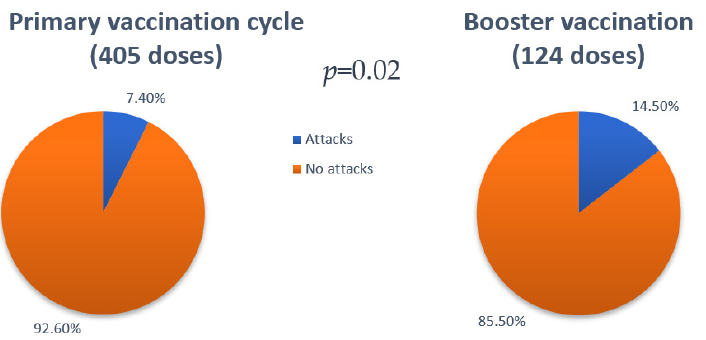
Figure 2. Difference regarding the percentages of doses followed by an angioedema attack ( ≤ 72 h) between the primary vaccination cycle and the booster vaccination (7.4% vs. 14.5%— p = 0.02).